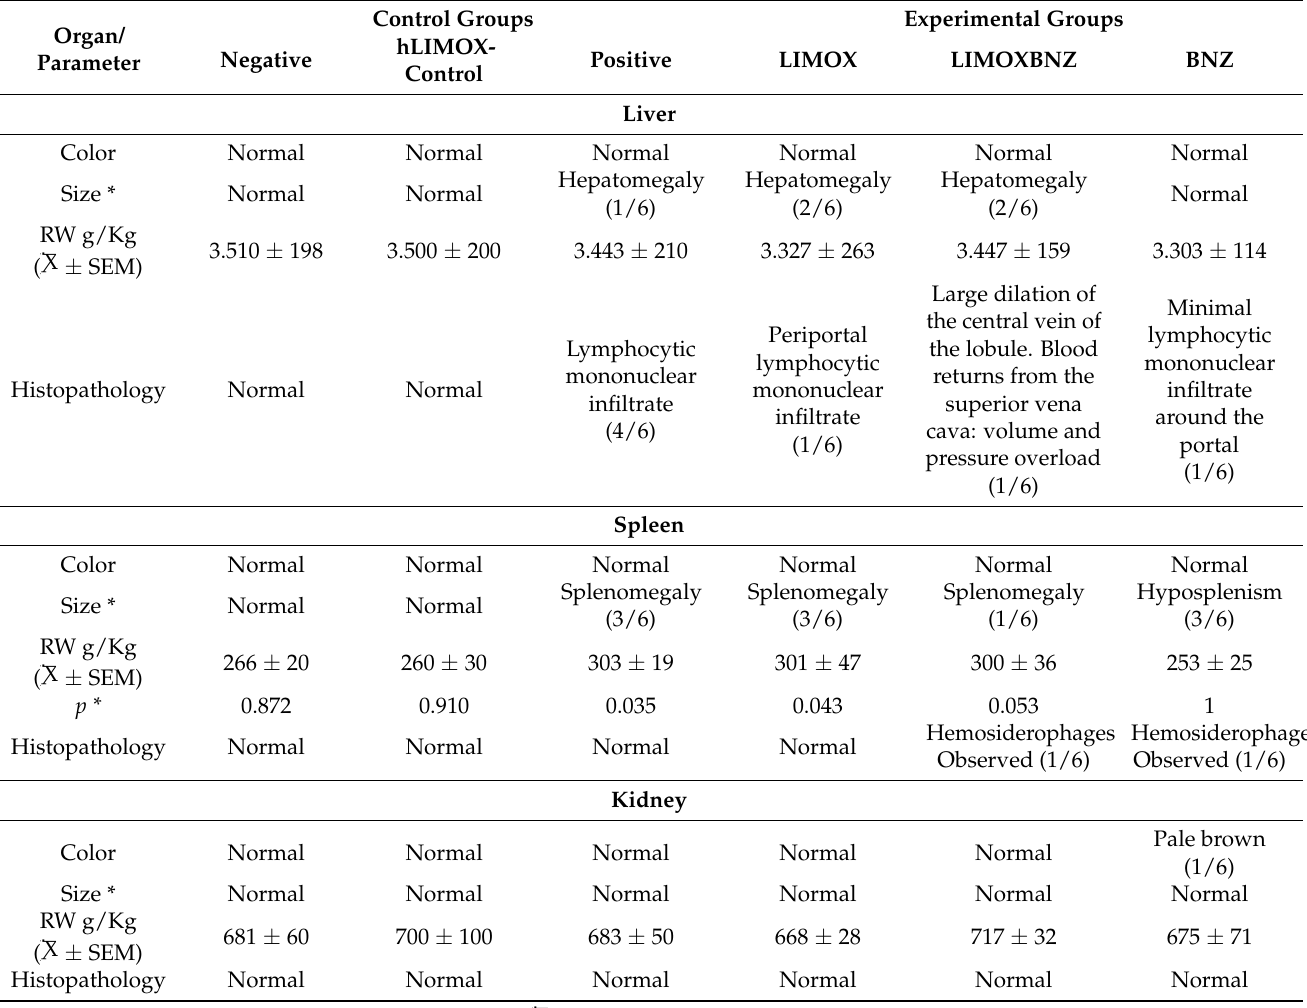
Table 5. Macroscopic and microscopic findings in organs of Wistar rats after receiving treatments. Table 3. Macroscopic and microscopic findings in the hearts of Wistar rats after receiving treatments.